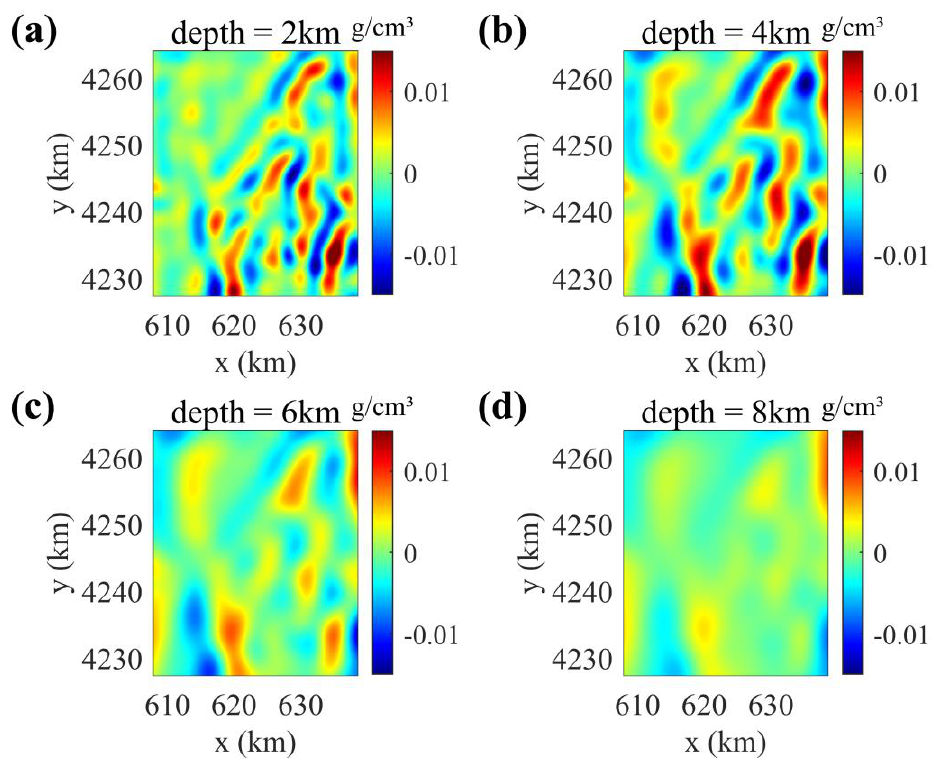
Figure 6. The horizontal section of the inversion results at ( a ) 2 km; ( b ) 4 km; ( c ) 6 km; ( d ) 8 km.